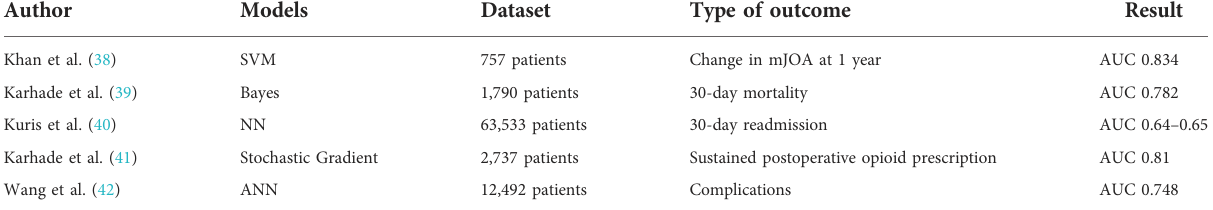
TABLE 3 AI and ML in the task of predicting the